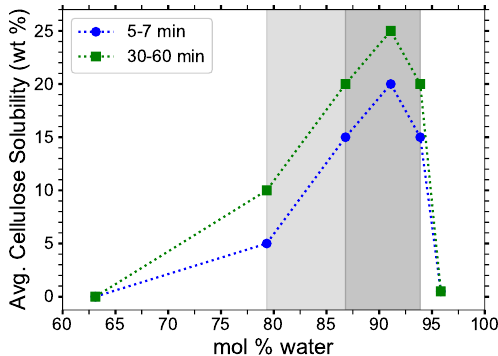
Figure 1. Cellulose solubility in tetrabutylphosphonium hydroxide (TBPH)-water solution as a function of water concentration for p = 1atm and T = 298.15K. The experimental cellulose solubility ranges are shown throughout the paper, and were broken down into two different ranges. Light gray shading shows where cellulose is soluble, but not ideal (79.4 to 86.8mol% water). Dark gray shading shows the maximum cellulose solubility range (86.8 to 93.9mol% water). Data from Abe et al. [2].